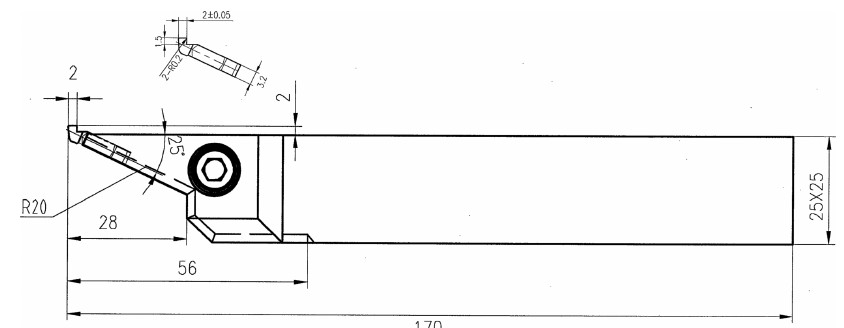
Figure A2. Sample No. A0050 cutting tool